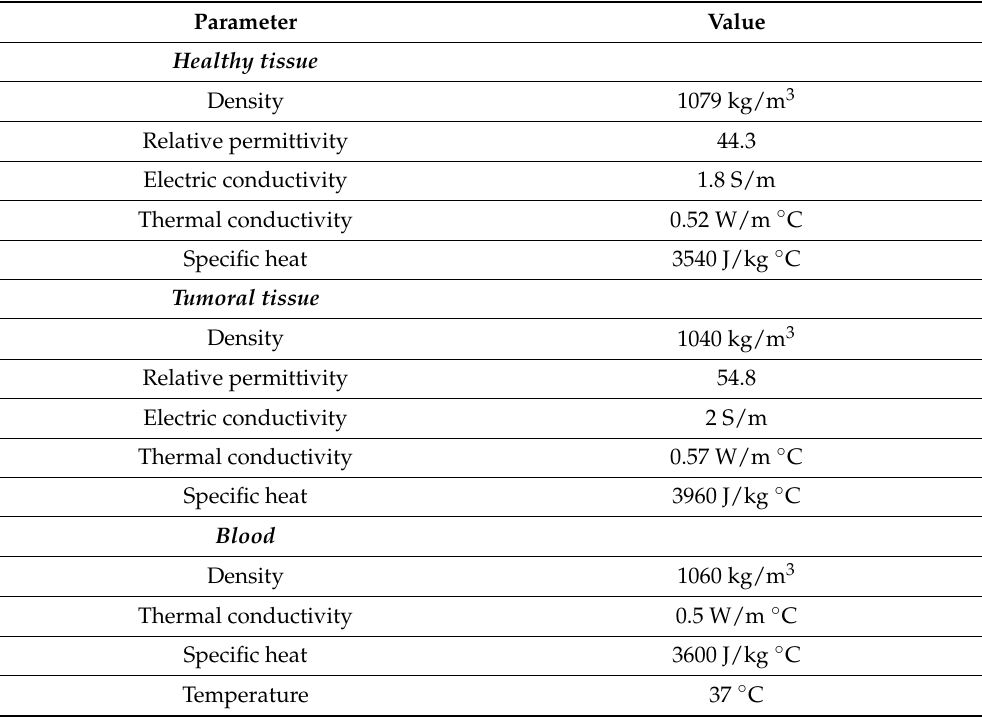
Table 1. The parameters that characterize the liver tissue (healthy and tumoral) and the blood collected from the literature [48,56] and used in the numerical